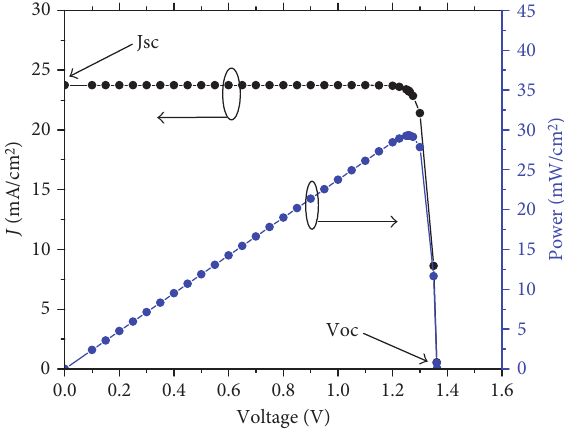
Figure 7: PHIBL versus Jsc plot of the proposed solar cell ’ s back contact.